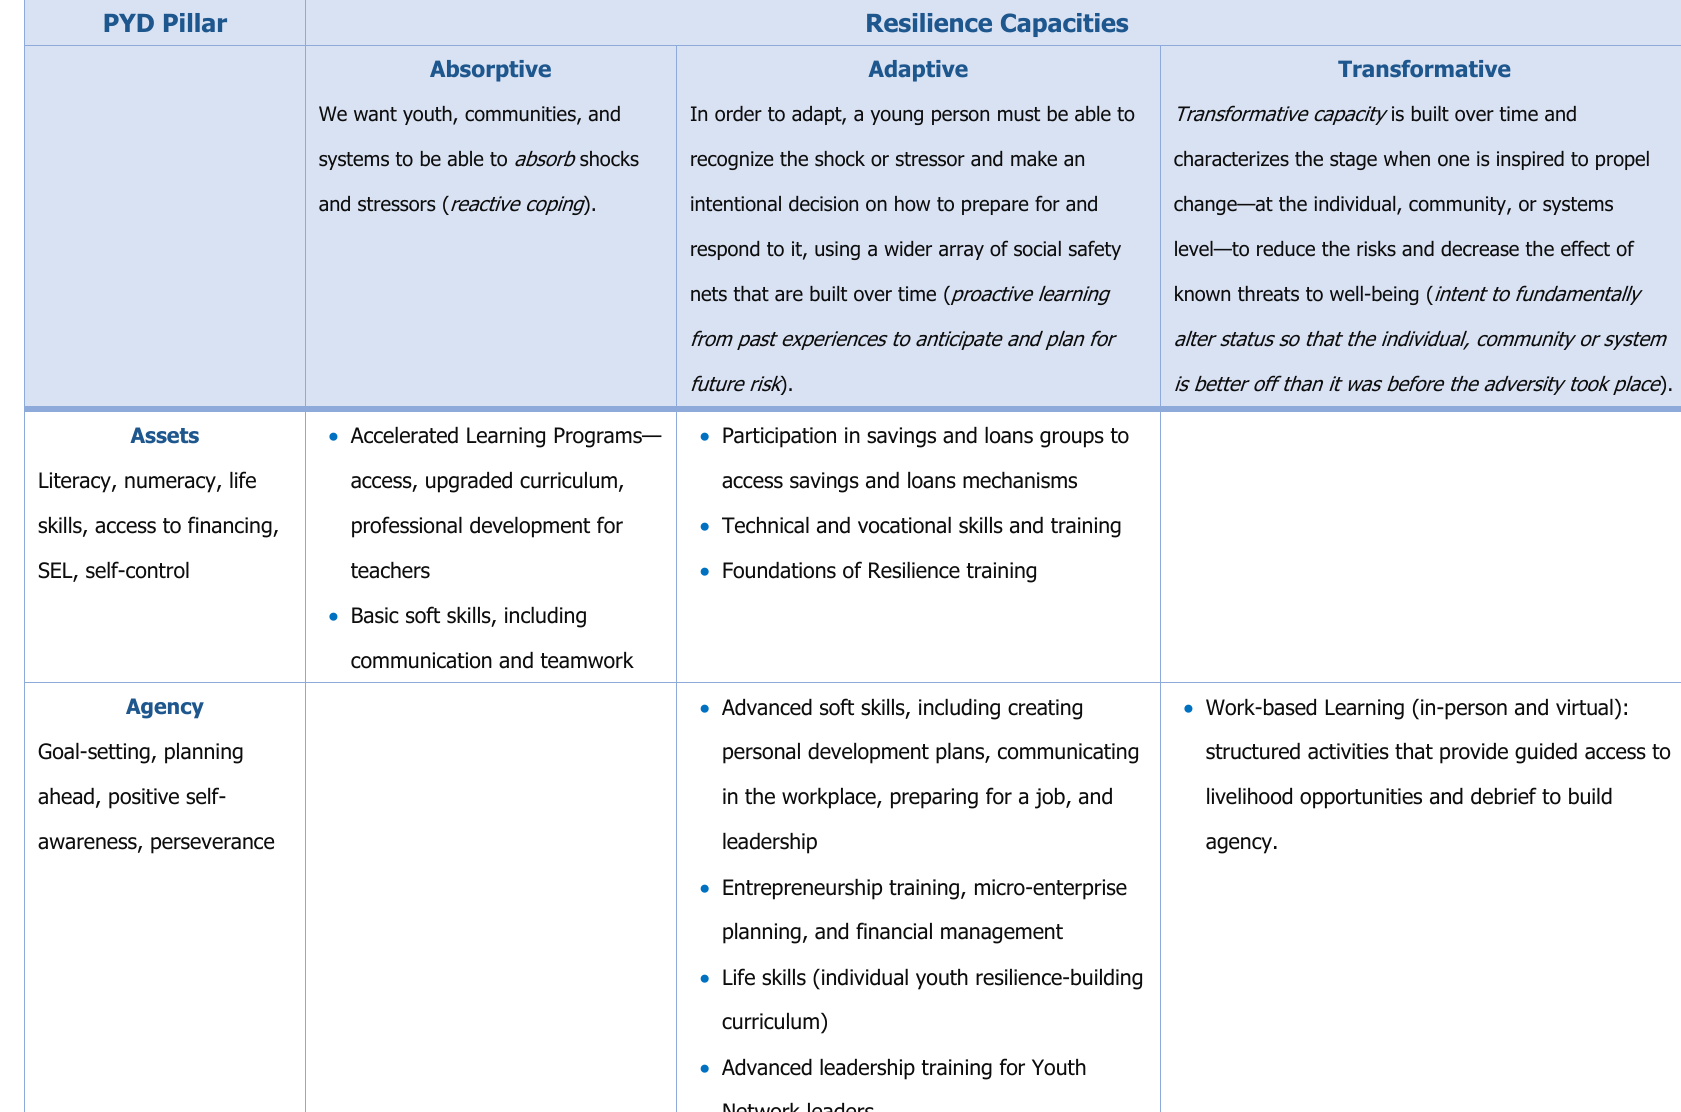
Table 1. Where PYD Domains and Resilience Capacities Intersect at the Individual Level PYD